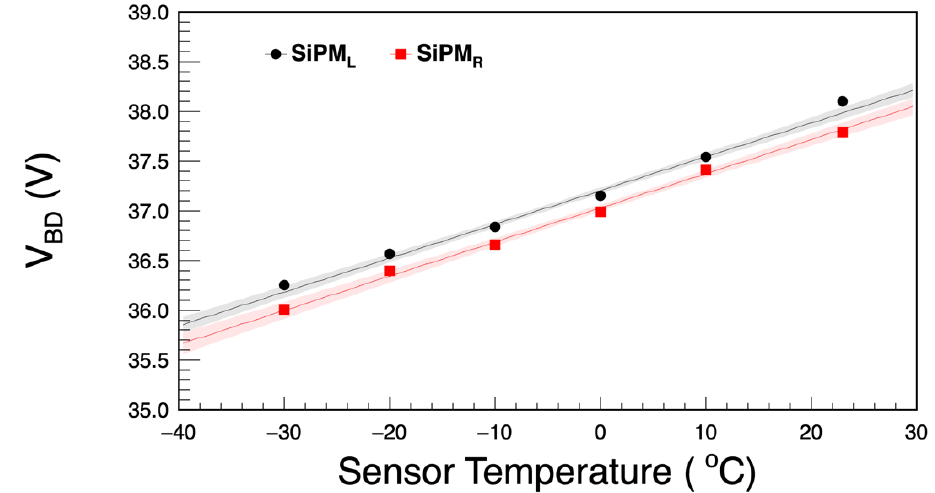
Figure 5. Dependence of the breakdown voltage ( V BD ) on temperature for two SiPMs. The breakdown voltage is obtained by measuring signal pulse heights with a 90 Sr source. As the temperature decreases from +23 ◦ C to − 30 ◦ C, the V BD decreases from 38 V to 36 V. The black and red error bands indicate the 95% confidence level of the